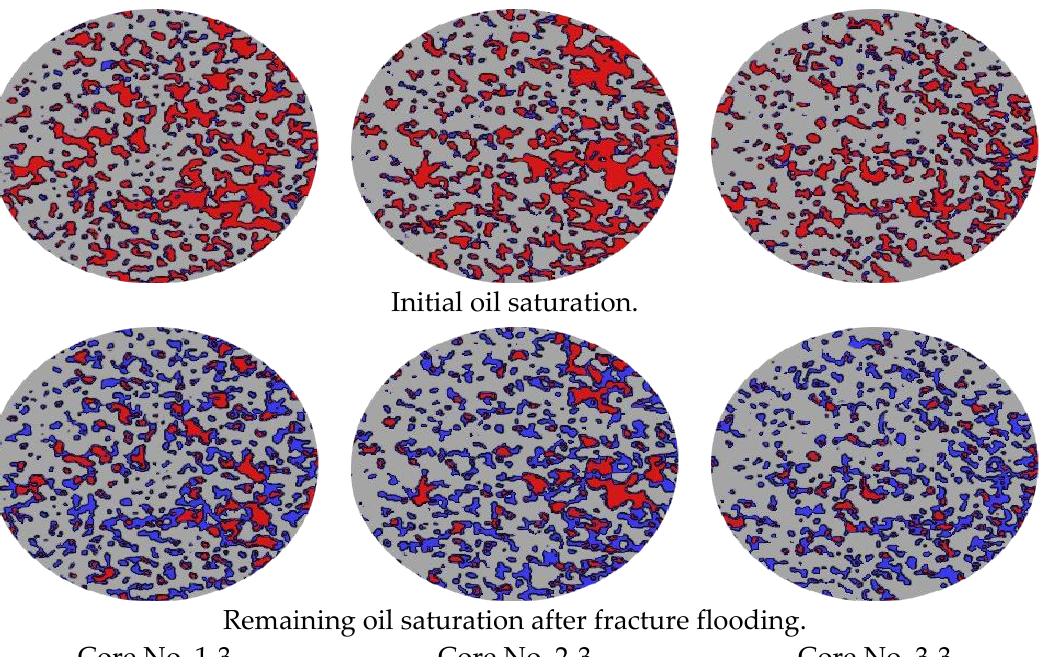
Figure 13. Two-dimensional distribution map of remaining oil during the water flooding stage constructed after CT scan.